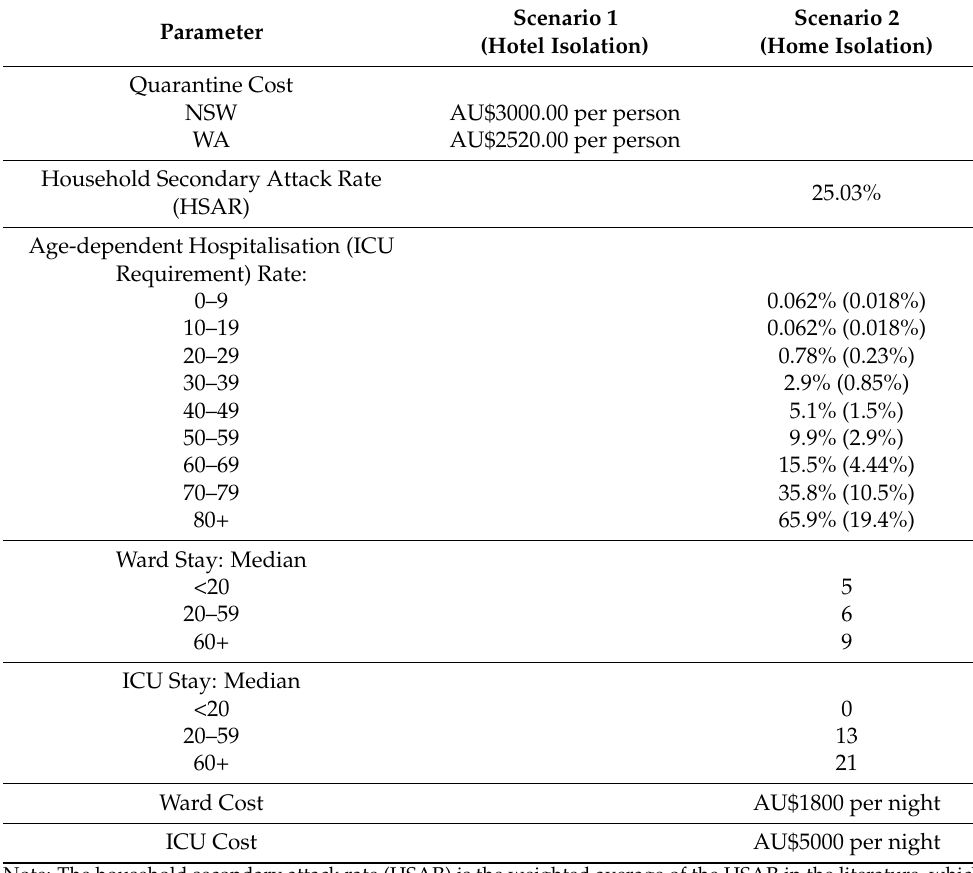
Table 1. The list of parameters incorporated in the decision